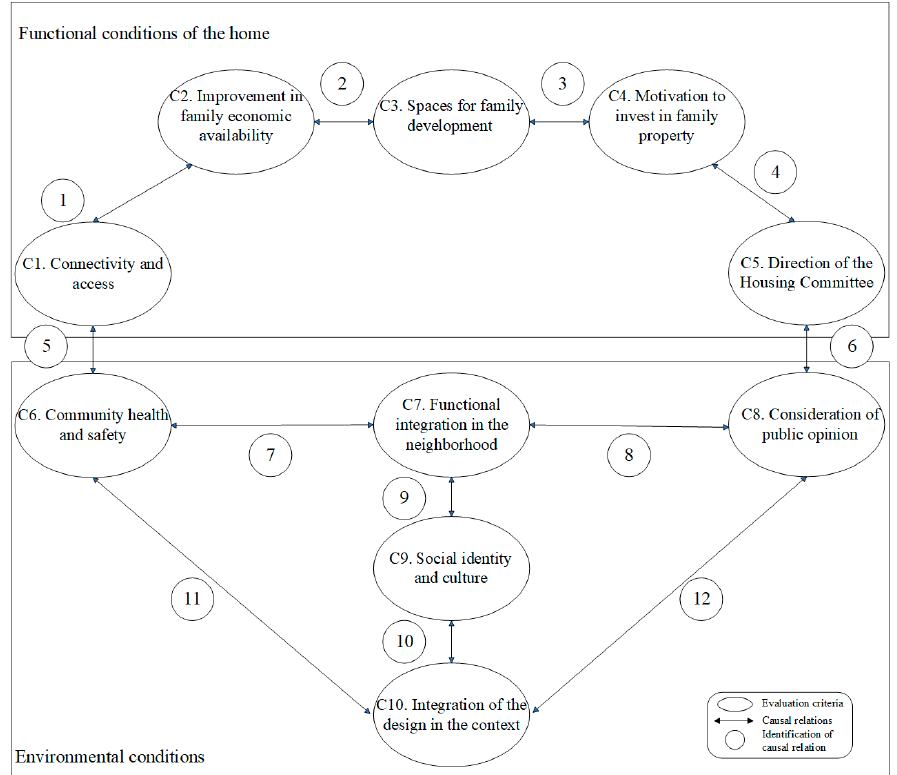
Figure 1. Initial conceptual model among public housing social criteria.